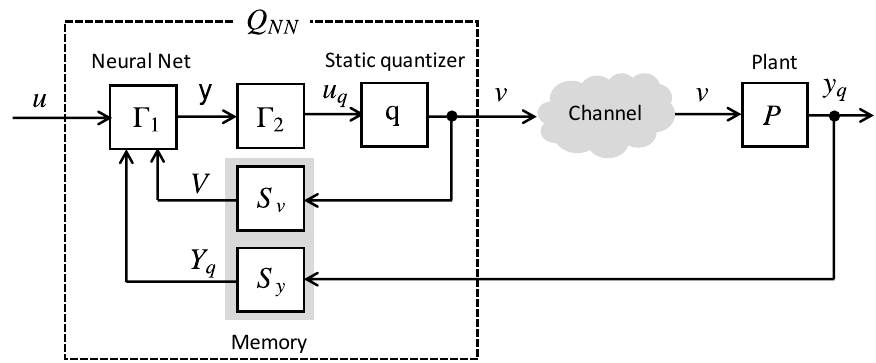
Figure 1. Considered system with a neural network quantizer Q NN